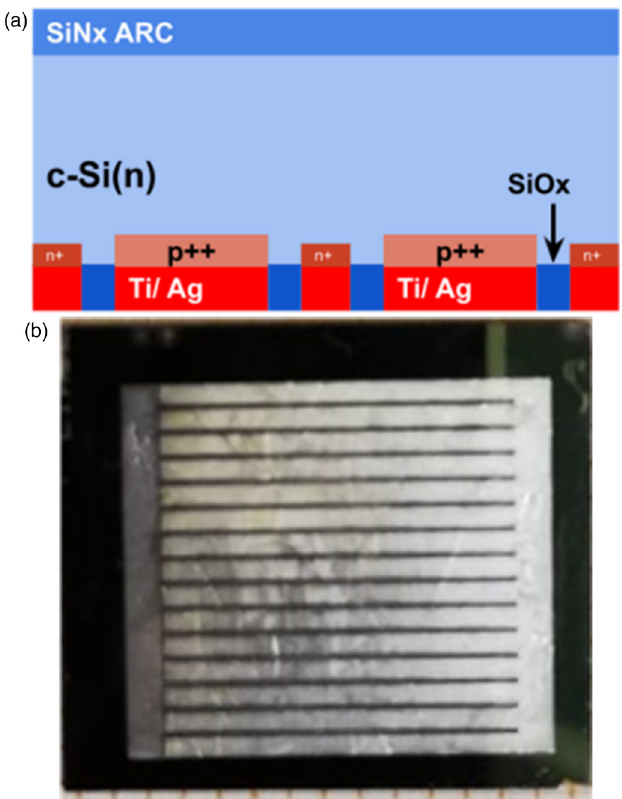
Fig. 3. Schematic (a) and back side image (b) of the silicon interdigitated back contact solar